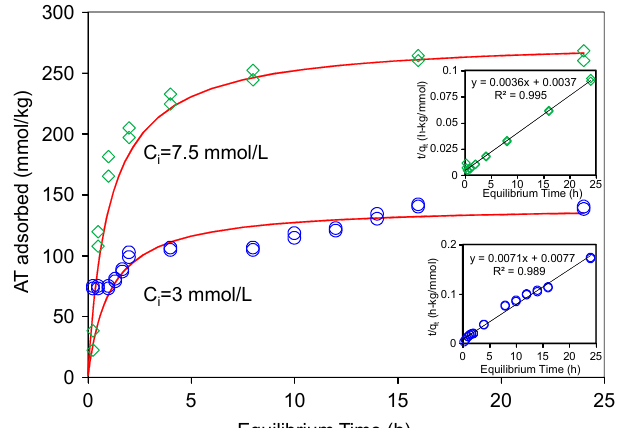
Figure 2. Sorption kinetics of AT on SAz-2 at pH10 under initial concentrations of 3 and 7.5 mmol/L, respectively. The solid line is pseudo-second-order model fitting of the observed data. Inserts are the linear plots of Equation (1).